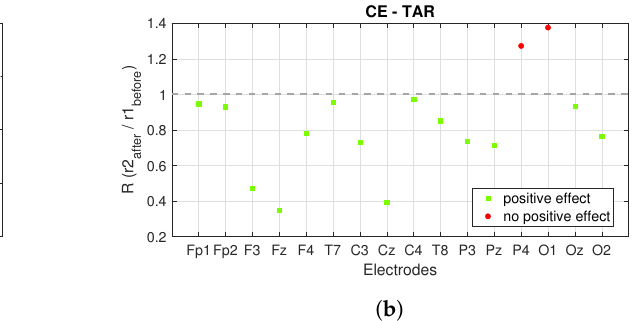
Figure 10. The long-term effect of PBM stimulation on the power spectrum is observed using TAR . ( a ) shows the ratios of TAR between the r 2 after and the r 1 before stimulation in the OE condition, and ( b ) shows the ratios of TAR in the CE